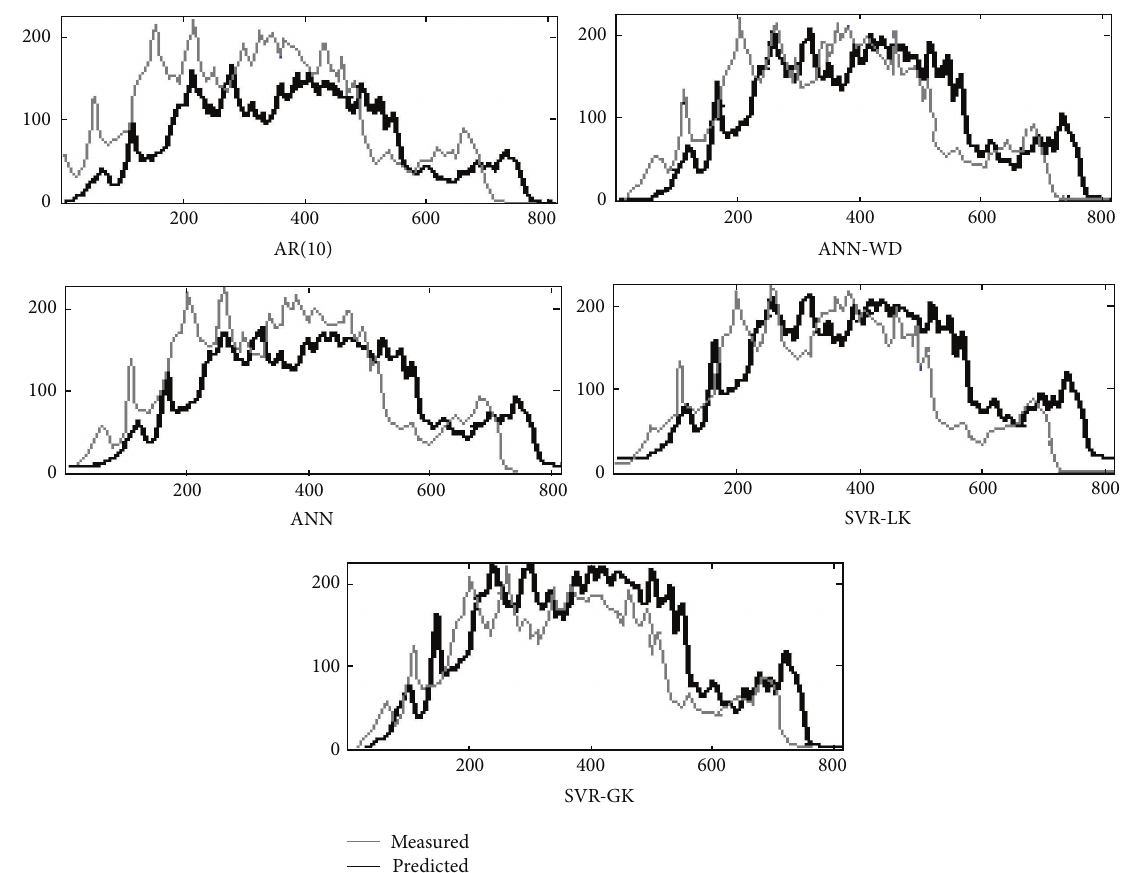
Figure 7: Sixty-step ahead prediction for one day of solar radiation using five different methods: a linear AR model, two distinct artificial neural networks models (ANN and ANN-WD), and two support vector regression models with different kernel functions (SVR-LK and SVR-GK). The vertical axis units are W/m 2 and horizontal axis is the time expressed in